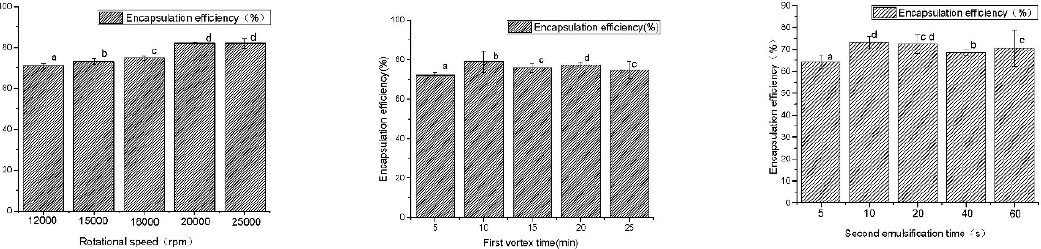
Figure 1. The results of the preparation technology. a–d Different superscript letters in the same series indicate statistical difference ( p < 0.05).